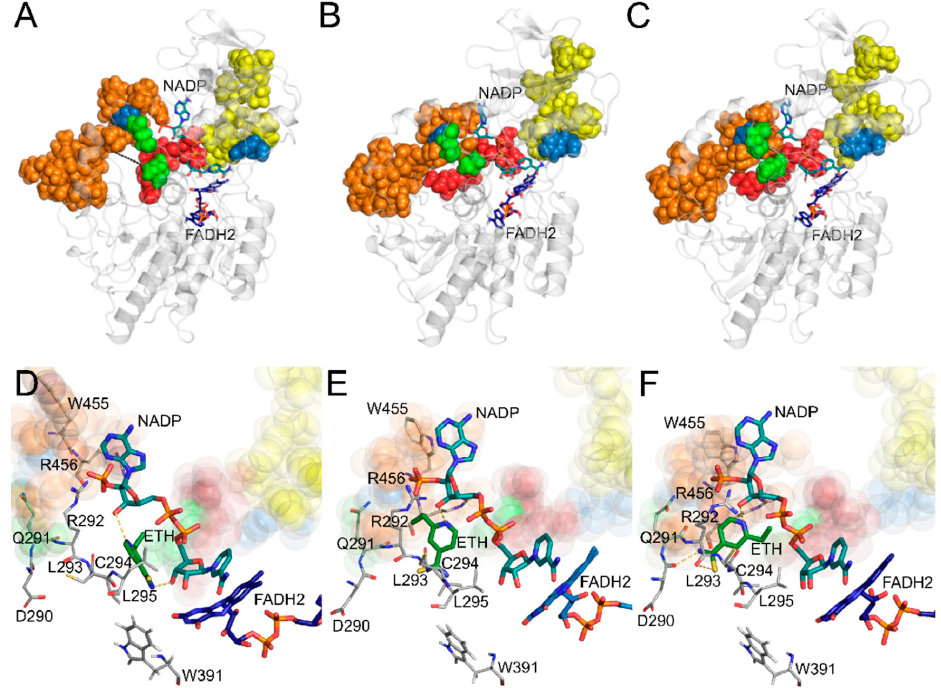
Figure 4. Control loop position and ETH docking in the selected conformations from the Spectral clustering results. BVMO motif (yellow), interdomain linker (red), control loop (orange), ETH binding region (green) are represented by spheres. Blue, Y50 and T453I. NADP (cyan) and FADH 2 (blue) are shown in stick representation. The distance between the interdomain linker (L348:CA) and control loop (N460:CA) in conformations ( a ) 01346 (12.7 Å), ( b ) 13841 (8.5 Å), and ( c ) 14053 (9.4 Å) are represented by black dashes. Best poses of ETH obtained from docking results in the selected conformations from the Spectral clustering results. ( d ) 01346, ( e ) 13841 and ( f ) 14053. ETH was docked into the region encompassed by amino acids R292-L295, whose interaction with ETH has been proposed for an EthA homolog in A. radioresistens [26]. The putative binding site includes R292 of EthA, a conserved catalytic arginine (Figure 4d − e). Con fi gurations in which the interdomain linker and control loop remained closer (13841 and 14053) were also the ones yielding lower values of interaction energy, indicating more stable ETH binding (Table 1). In the A. radioresistens EthA homolog model, the interaction energy of ETH upon docking was higher [26], indicating a less stable interaction than found here for M. tuberculosis EthA. The docked systems were used for further characterization of the ETH-EthA interaction. It is interesting to point out that in configurations with proximal interdomain linker and control loop (13841 and 14053) ETH interacted with R456. This arginine is adjacent to conserved W455, whose movement together with the rest of the control loop has been described as essential in BVMO catalysis [20,24]. Table 1. ETH docking results show more favorable interaction with EthA conformations 13841 and 14053. EthA Conformation